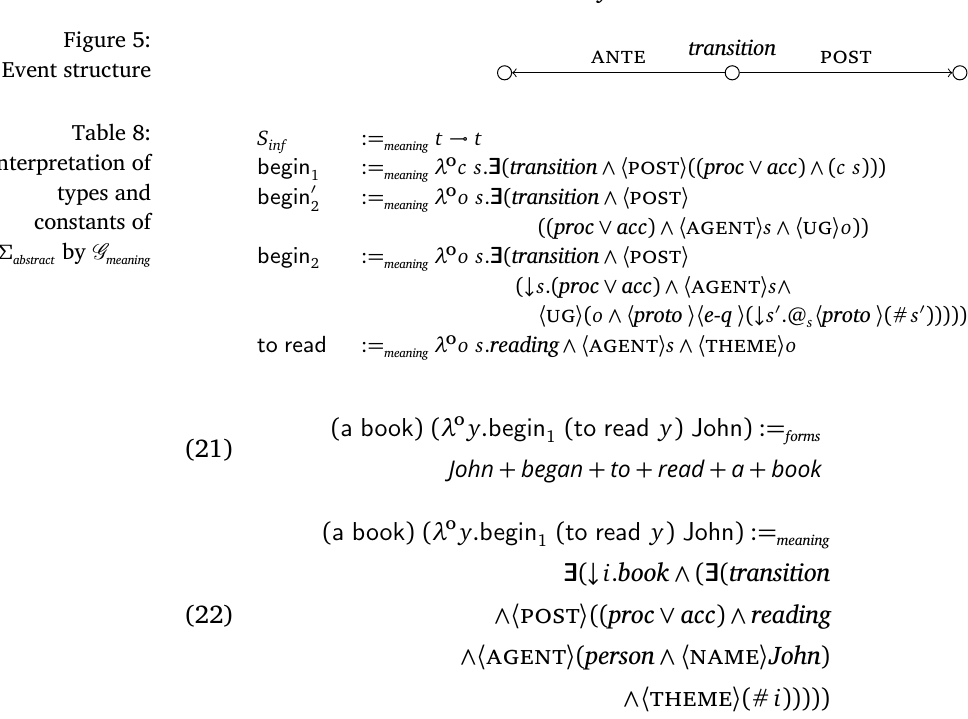
Event structure Interpretation